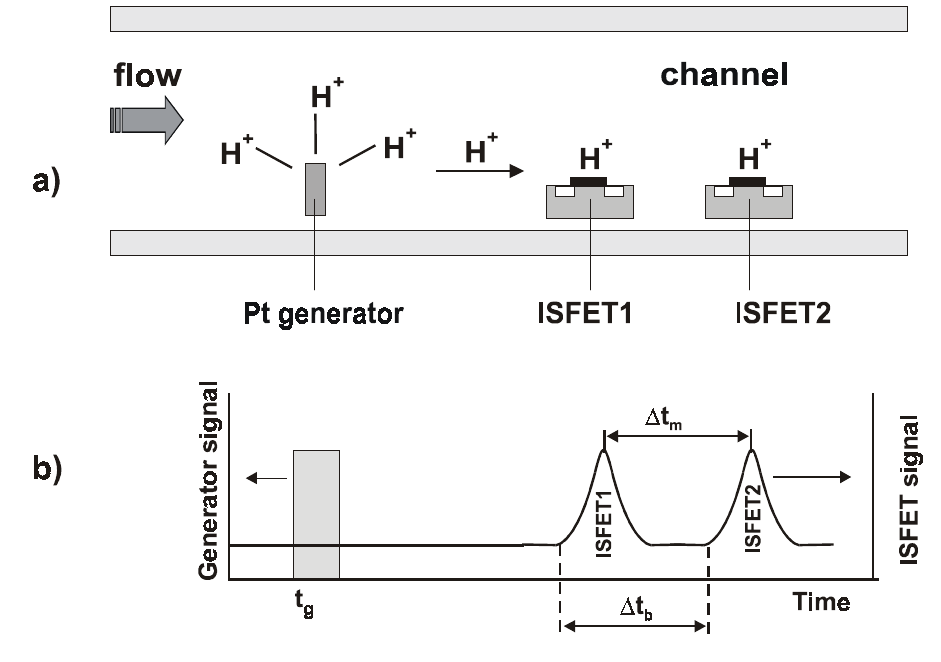
Figure 1. Flow-velocity sensor based on an ISFET array (schematically): a) functional principle, b) time of flight